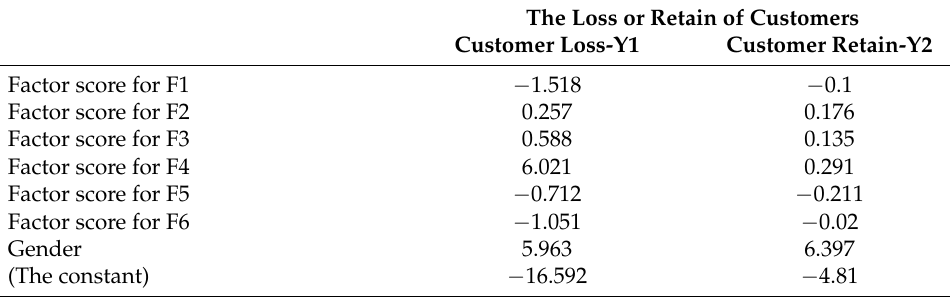
Table 19. Classification function coefficients—adapted from Zhang